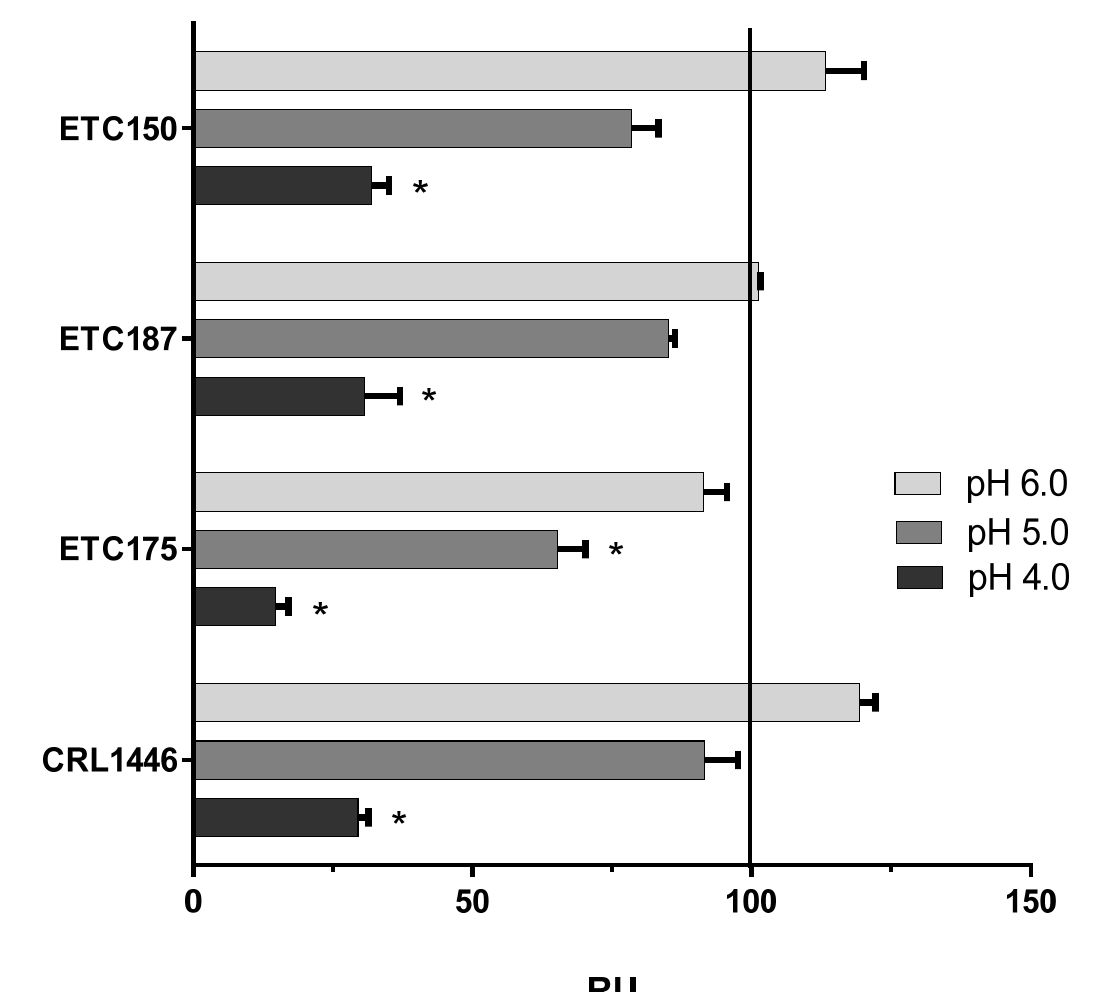
Figure 5. Effect of pH on FAE activity at 37 ◦ C. RU= relative FAE activity (mean ± SE) at different pH conditions for each strain, considering mean U g − 1 at pH 7.0 as 100% (black line, standard condition, StdC). An * indicates statistical difference ( p < 0.05) in comparison with results at StdC for each strain.